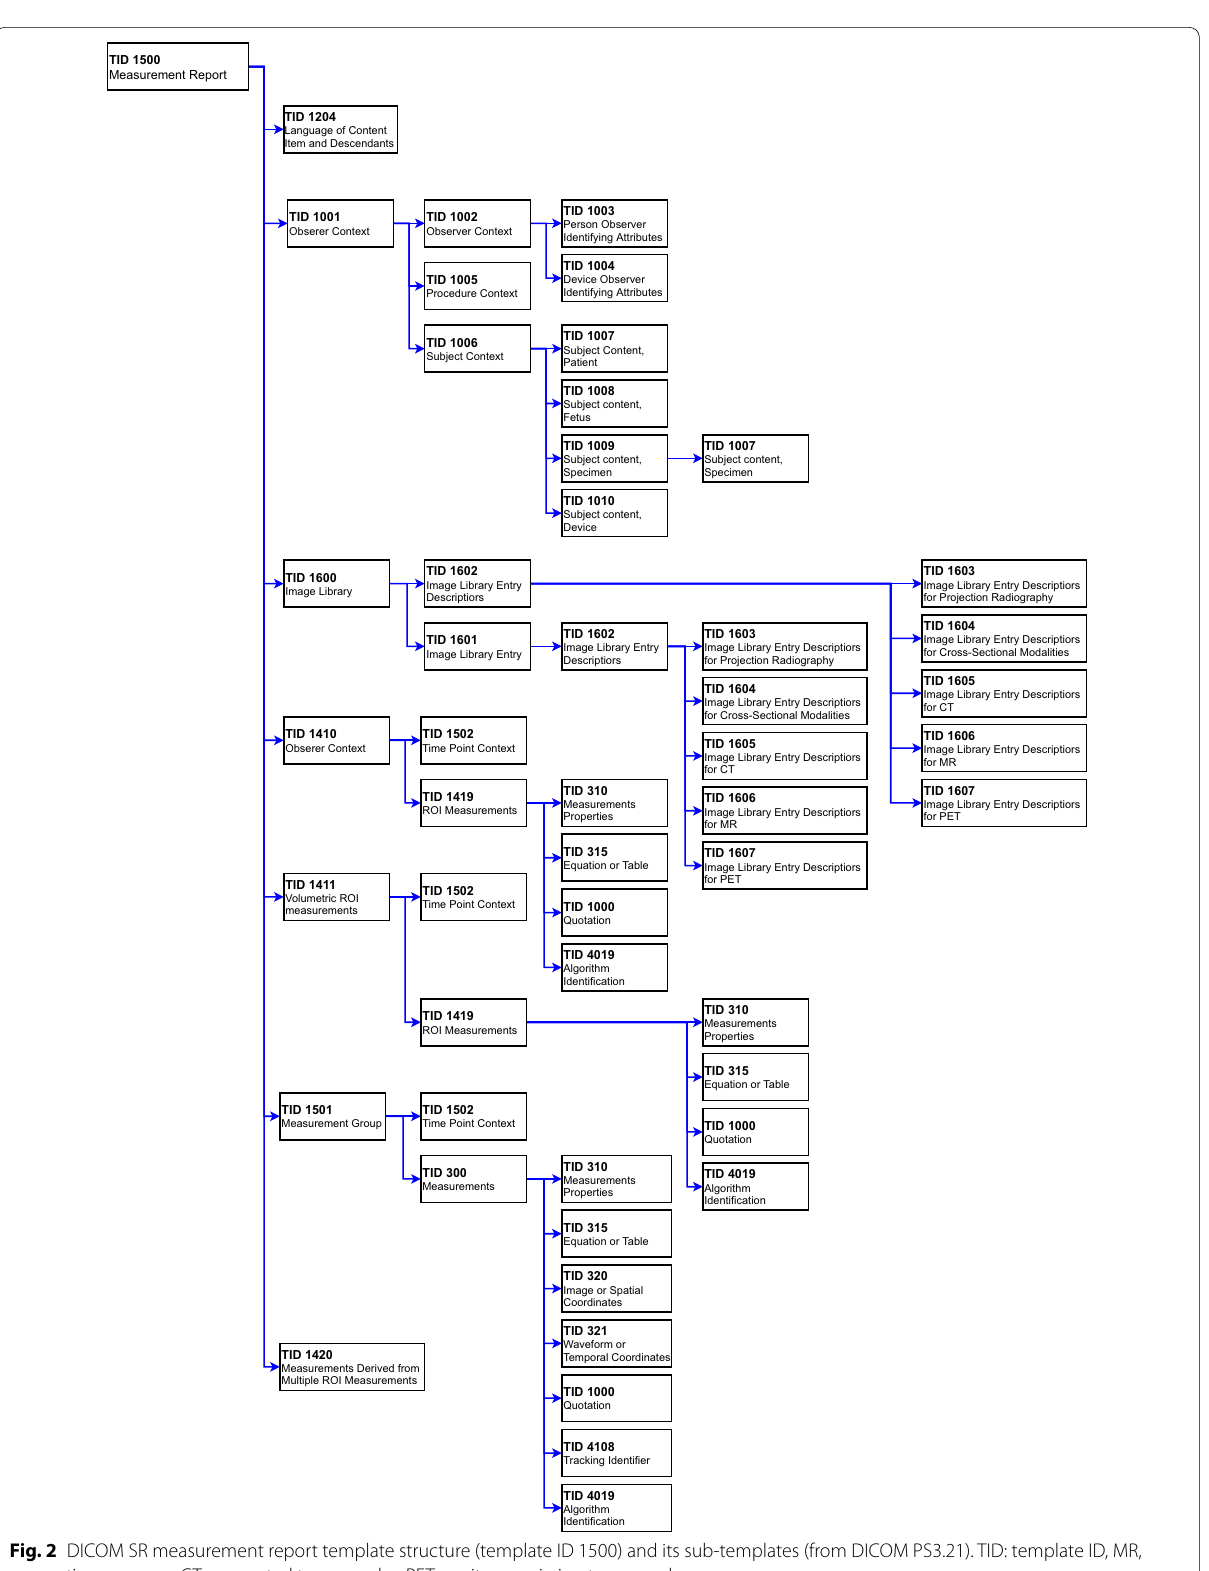
Fig. 2 DICOM SR measurement report template structure (template ID 1500) and its sub-templates (from DICOM PS3.21). TID: template ID, MR, magnetic resonance; CT, computed tomography; PET, positron emission